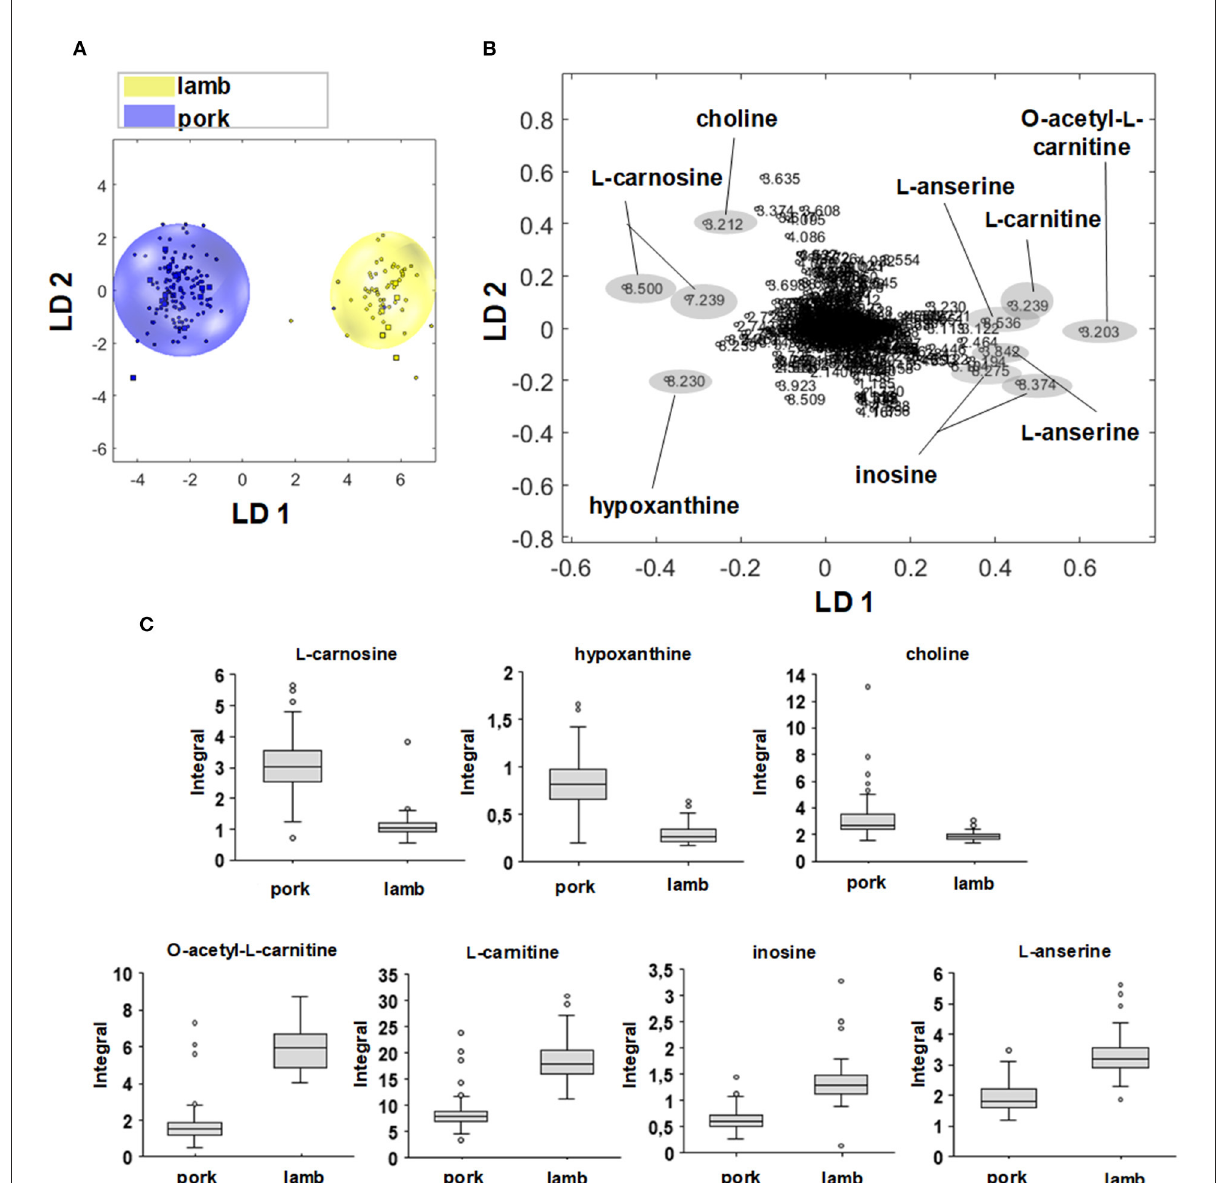
FIGURE5 (A) Two-dimensional PCA/LDA score plot of the sample groups lamb (yellow) and pork (blue). (B) Associated loading plot with the 967 buckets used. Buckets with the highest positive or highest negative values along LD 1 are marked and correspond to signal regions that are more distinct in the respective sample group. (C) Box-Whisker-Plots of metabolites that are relevant for the discrimination of pork vs. lamb. Buckets that showed an effect on discrimination in the loading plot were used for the Box-Whisker-Plot. Box-Whisker-Plots of L -carnosine, hypoxanthine, and choline demonstrate higher concentrations in beef meat. Box Whisker-Plots of L-anserine, inosine, L-carnitine, and O -acetyl-L-carnitine demonstrate higher concentration sin lamb meat.